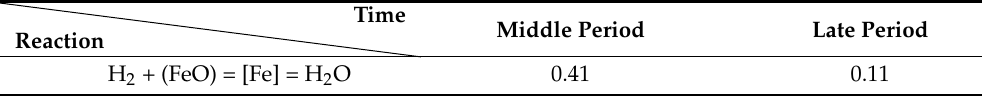
Table 10. Equilibrium partial pressure ratio of water and hydrogen for reaction H 2 + (FeO) = [Fe] + H 2 O. Time Middle Period Late Period Reaction H 2 + (FeO) = [Fe] = H 2 O 0.41